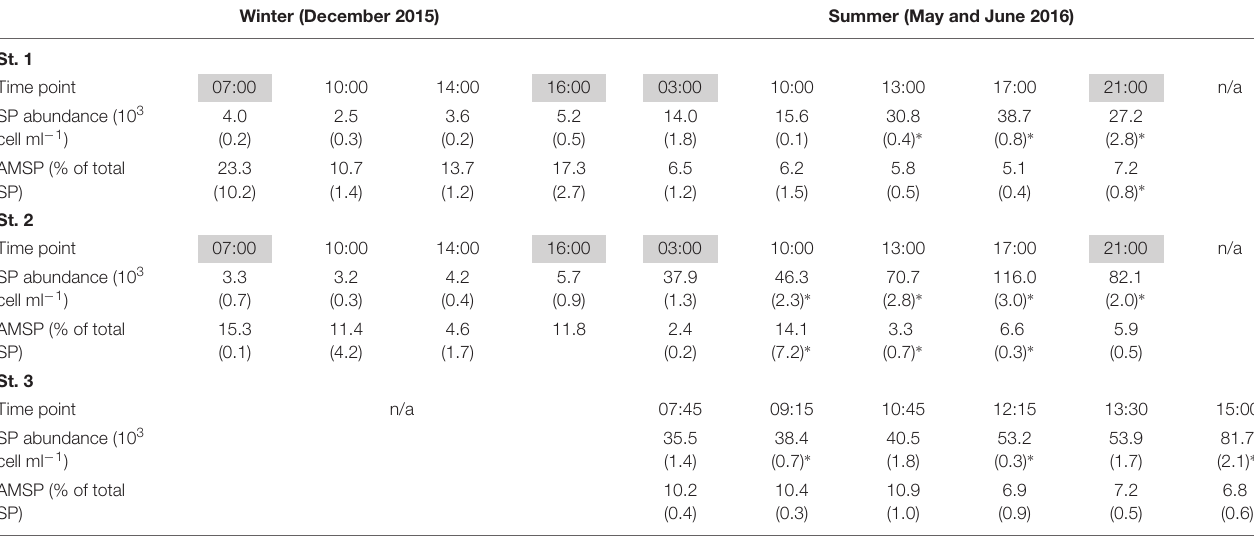
Shaded time points indicate night-time sampling. n/a: not applicable. ∗ Indicates significant differences with the previous time point (ANOVA, P < 0.05). In winter only duplicate measurements were taken and statistical comparison of the data was not possible.